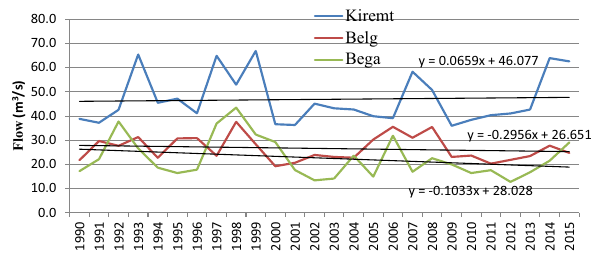
Fig. 10 mean seasonal discharge of the watershed